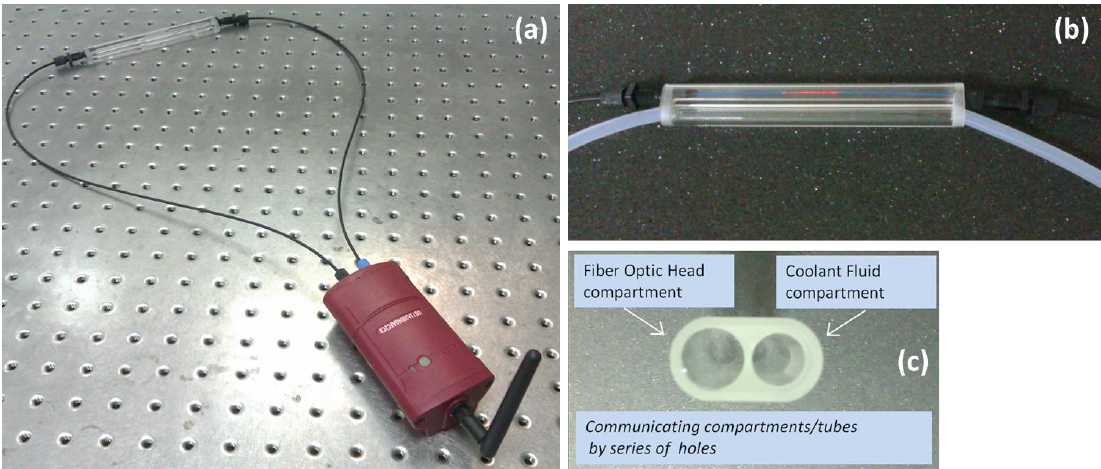
Figure 14. ( a ) Measuring apparatus with the sensing head connected to the wireless sensing node unit; ( b ) Photograph of the glass measuring cell with the two interconnected cylindrical inner compartments for the accommodation of the fiber optic sensing head and the coolant flow system; ( c ) Photograph showing in detail the dual tube glass cell.